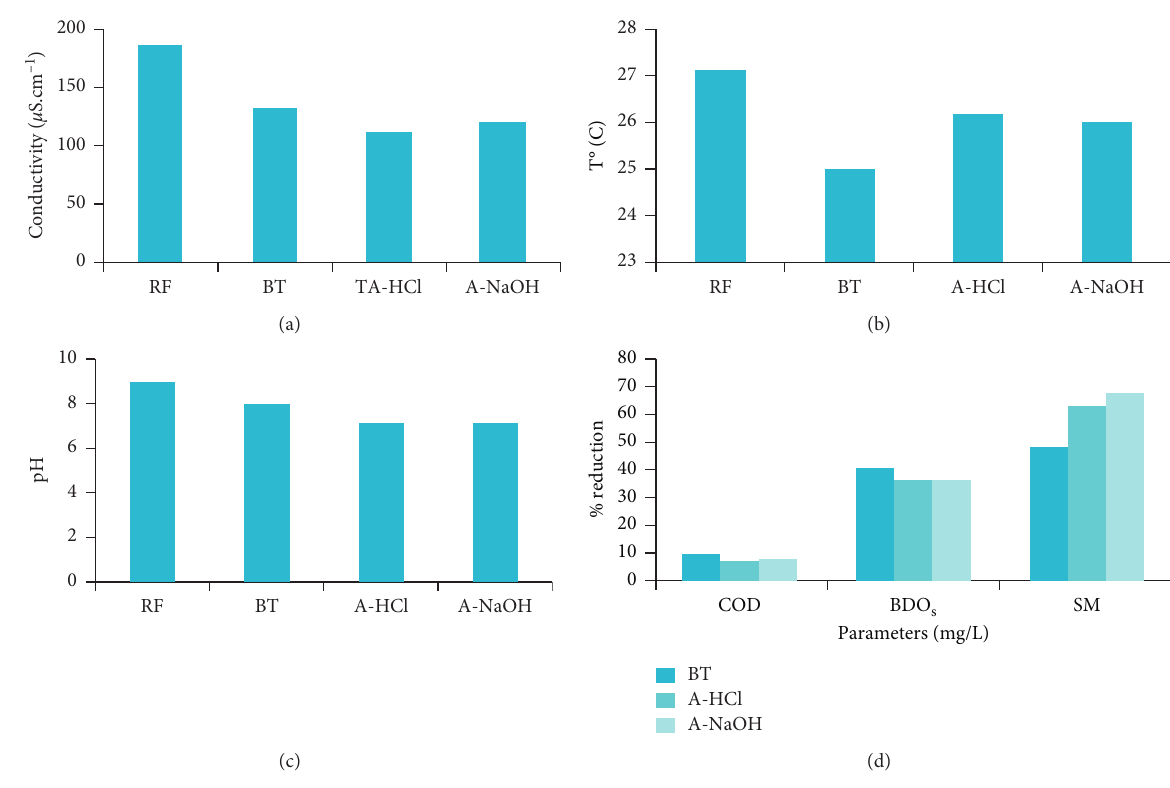
Figure 10: Characterization of the industrial effluent after